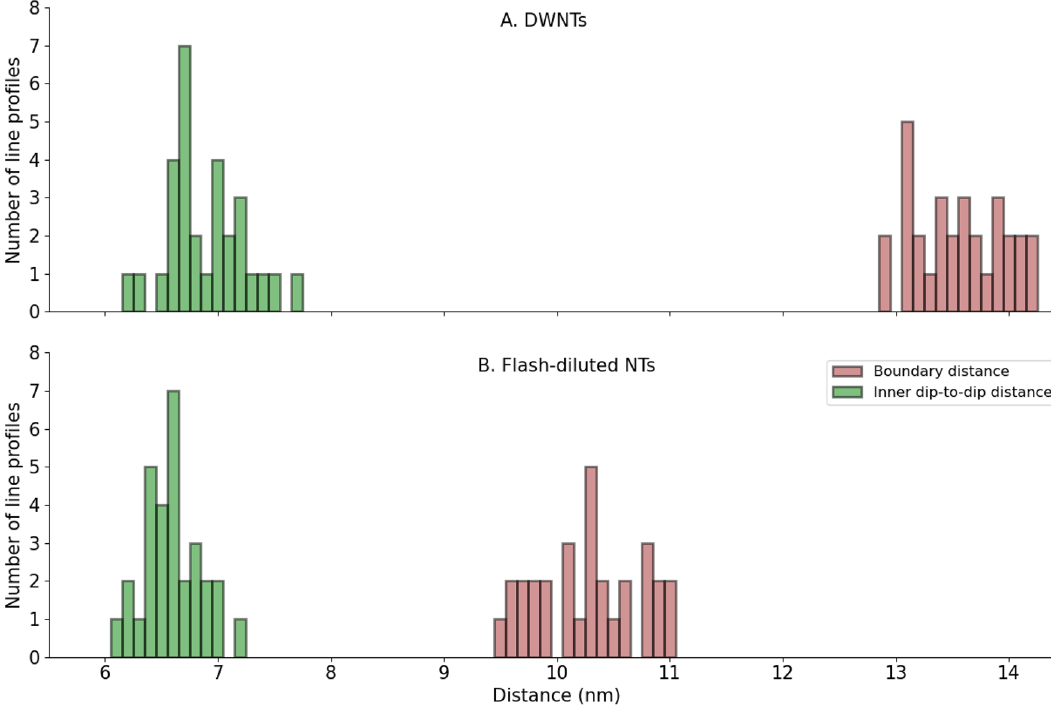
Figure 4. Histograms of boundary distances (brown) and inner dip-to-dip distances (green) of DWNTs ( A ) and flash-diluted NTs ( B ). Thirty line profiles of a total length of ∼ 0.7 µm were considered for DWNTs and flash-diluted NTs. Each line profile was averaged over a 22.5 nm length and fitted ad hoc with four (DWNT) or two (flash-diluted NT) Gaussians, from which the mean positions were extracted (Supplementary Information IV). The parameters of the histograms are listed in Table 1.